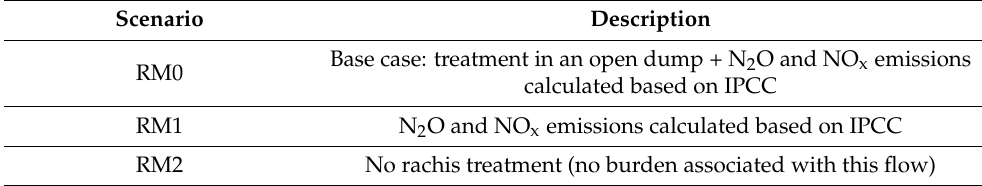
Table 2. Rachis management